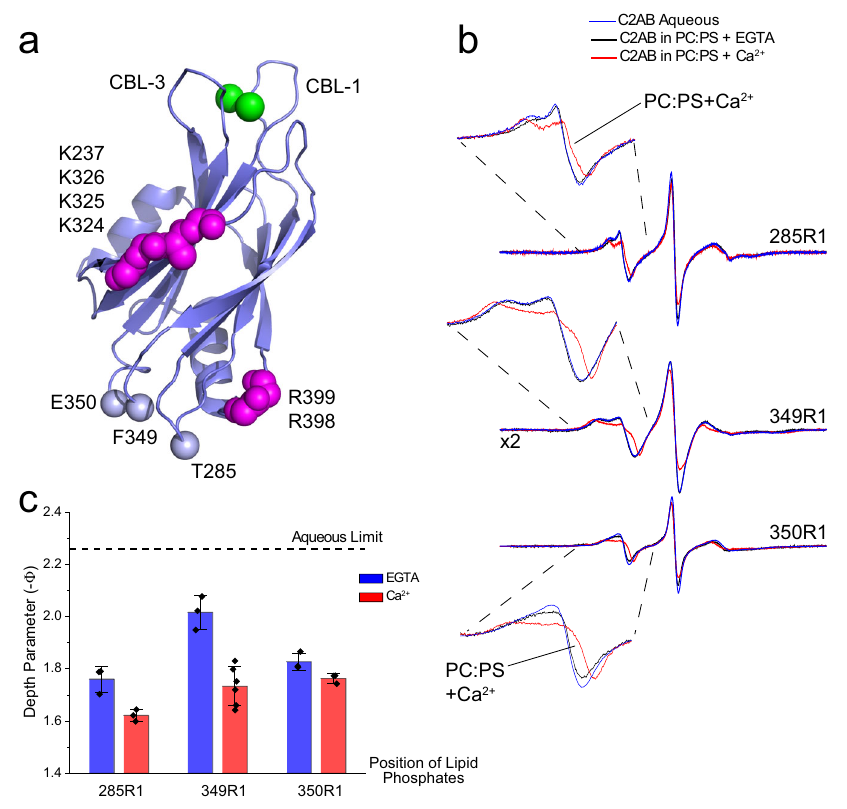
Fig. 2 The arginine apex of C2B contacts the membrane interface. a Model of C2B showing conserved arginine residues in the apex, lysine residues in the polybasic face and the three sites to which R1 was attached. The arginine apex is on the opposite surface of the domain from two Ca 2 + -binding loops (CBL) that insert into bilayers in the presence of Ca 2 + . b EPR spectra from the three labeled sites in the absence of membranes or the presence of POPC:POPS (80:20) lipid vesicles. c Membrane depth parameters obtained with and without Ca 2 + for labels near the apex. The bars indicate the mean value with ±standard deviation. Three independent samples and power saturation measurements were made, except for 349R1 with Ca 2 + where six samples were